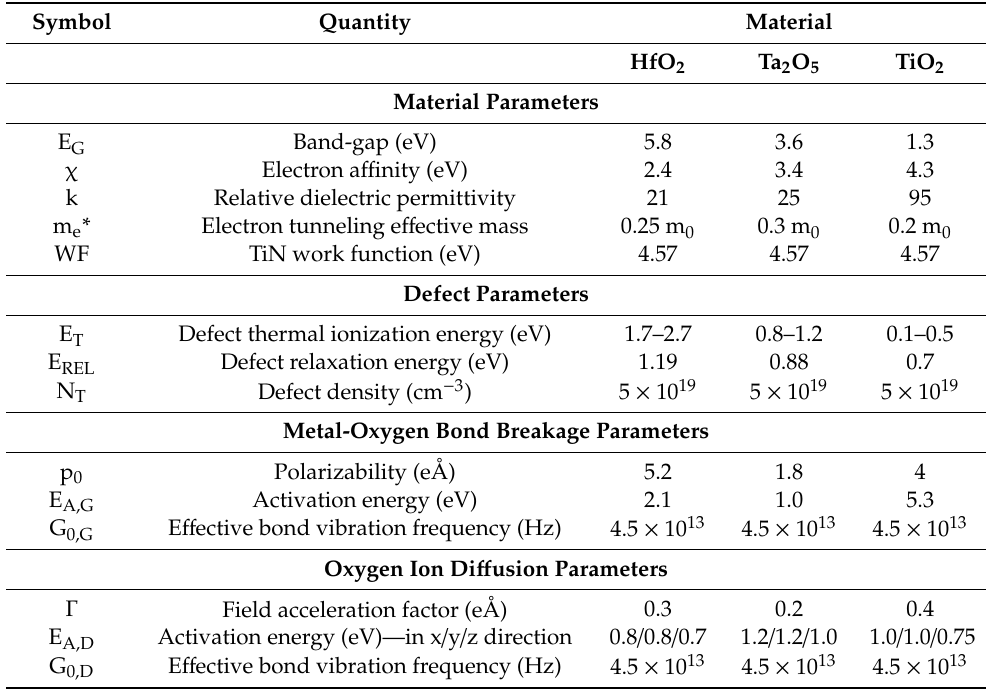
Table 2. Simulation